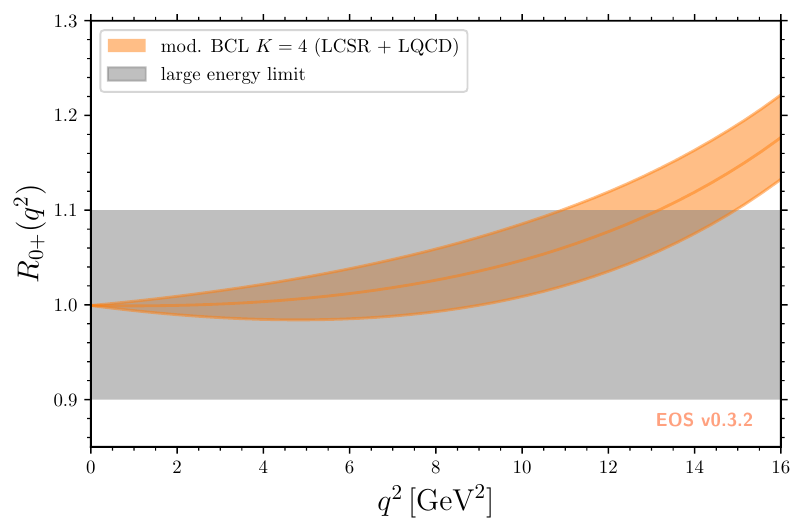
Figure 6 . The form factor ratio R 0+ ( q 2 ) interpolated between LCSR and LQCD data and com- pared to the large-energy symmetry limit in the low q 2